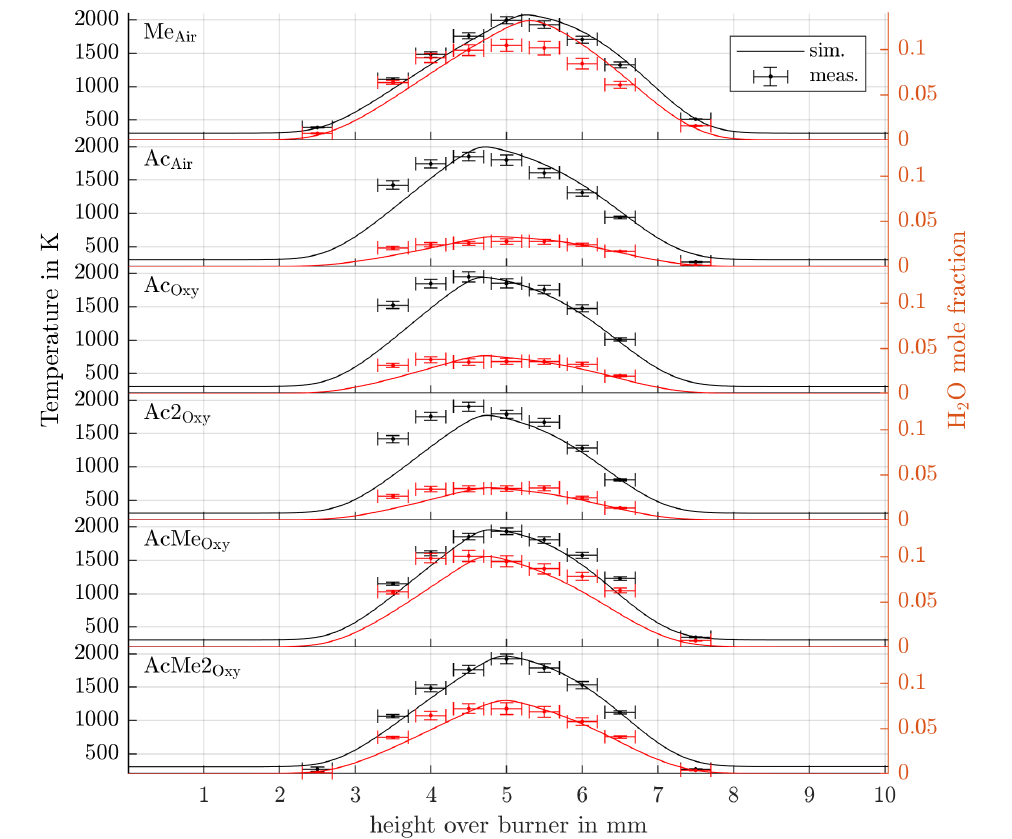
Figure 5. Reconstructed temperature and water mole fraction on burner center line in comparison to simulations. Vertical error bars represent the 3 σ -interval of statistical measurement error. Horizontal error bars represent the laser beam width at half